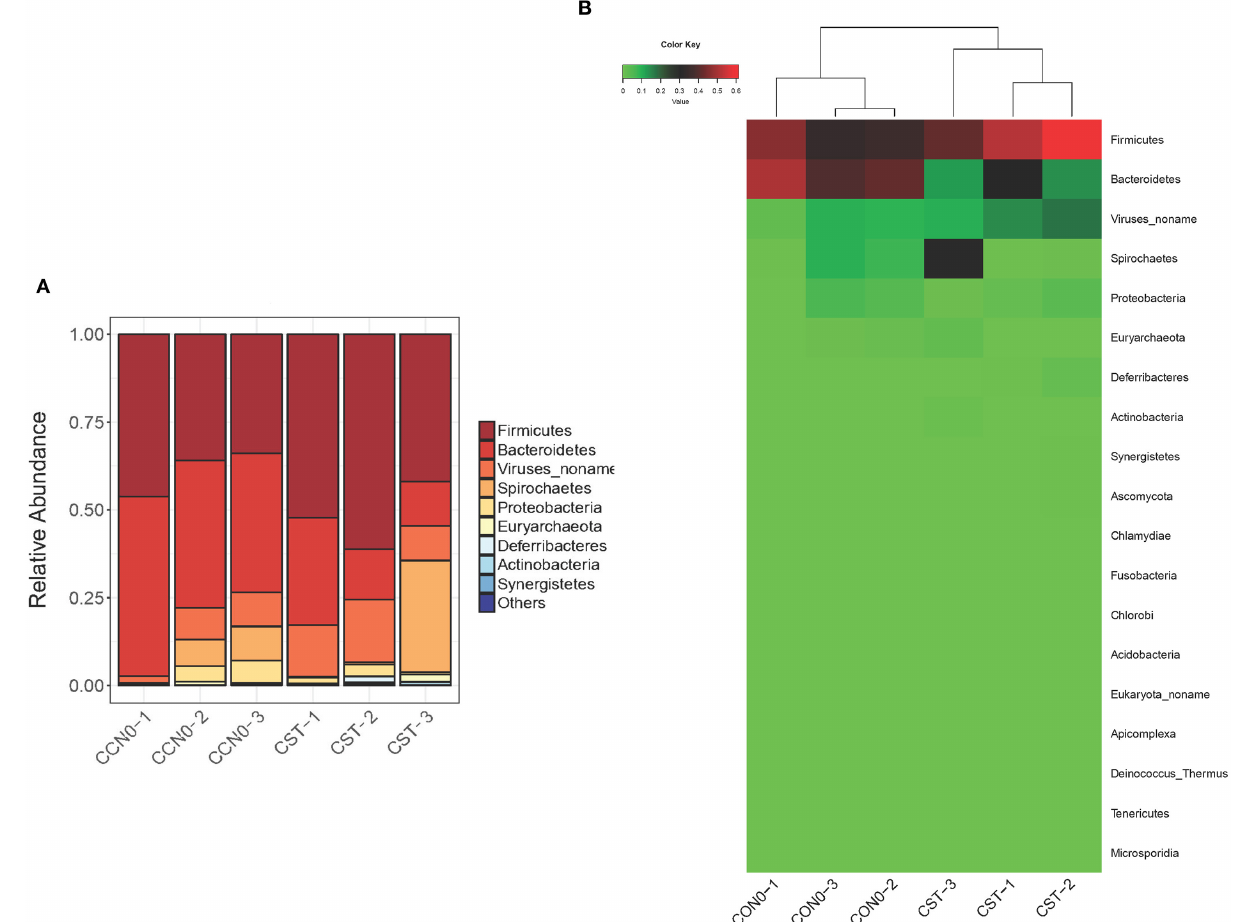
Phascolarctobacterium , and Acidaminococcus was